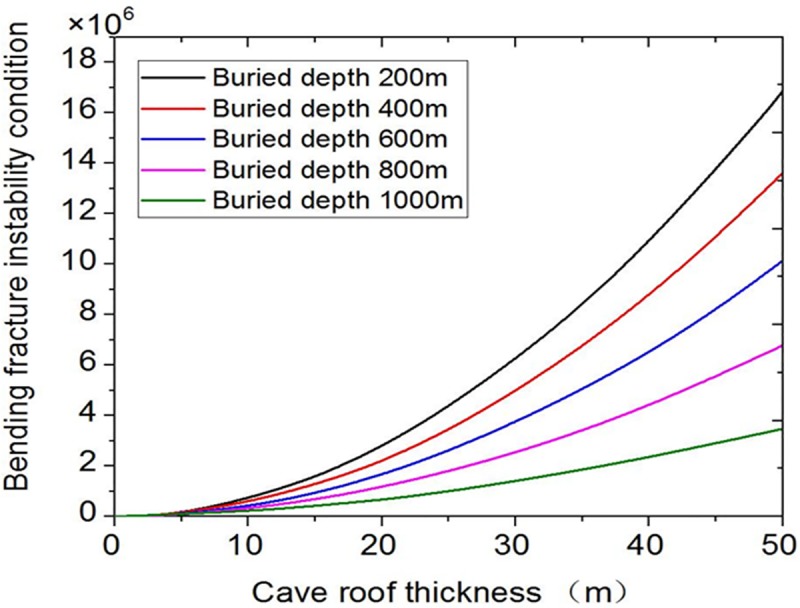
Influence curves of different buried depth.